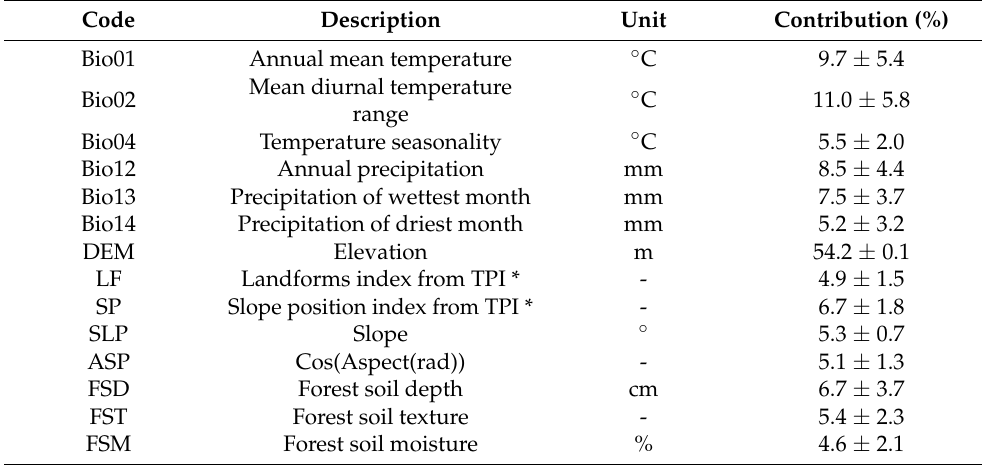
Table 2. Selected environmental variables with percent contribution of all species.